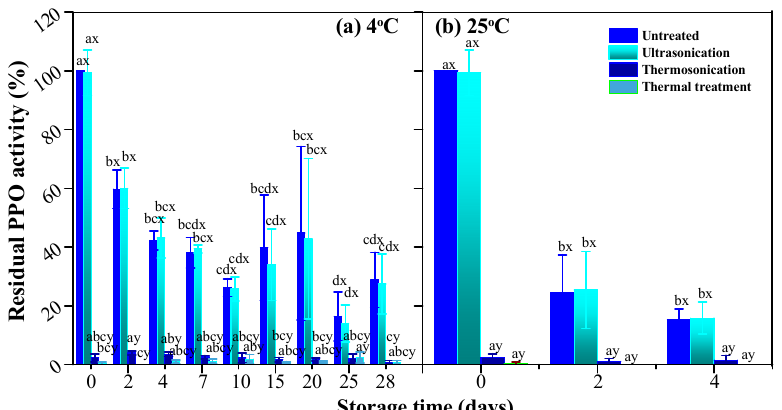
Figure 6. The residual activity of PPO in red pitaya juices during storage at 4 °C ( a ) and 25 °C ( b ), as subjected to thermosonication (475 W, 56 °C, 20 min), ultrasonication (475 W, 10 °C, 20 min), and thermal (83 °C, 1.5 min) treatments. a, b, c, d means significant difference with respect to storage time ( p < 0.05); x, y, z, i means significant difference with respect to various treatments ( p < 0.05).